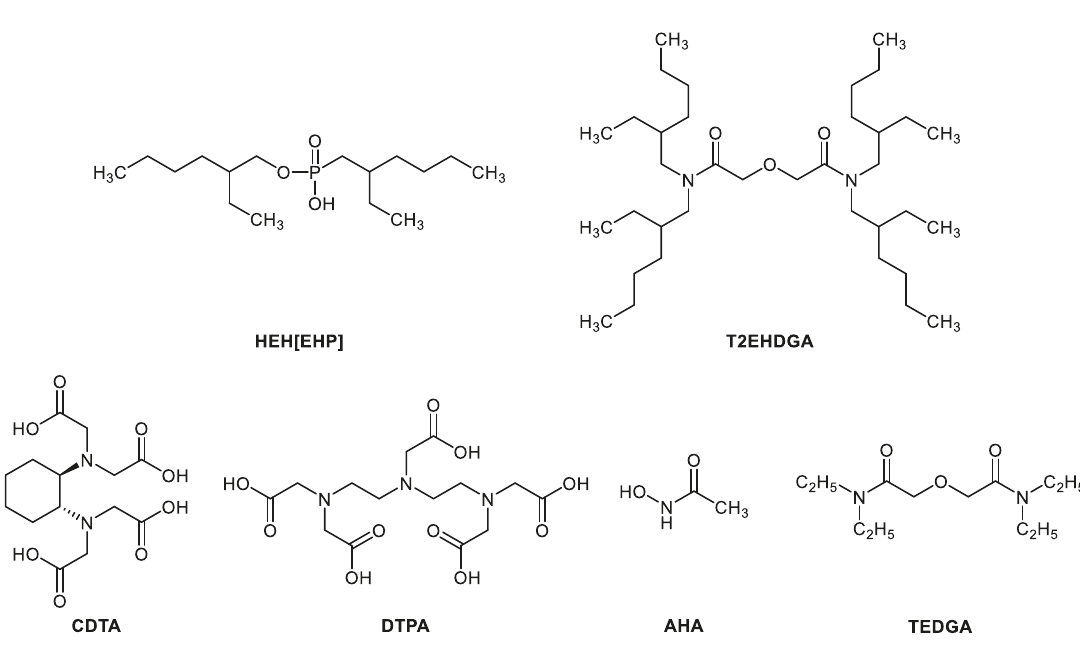
Figure 1. Chemical structures of molecules used in this study.